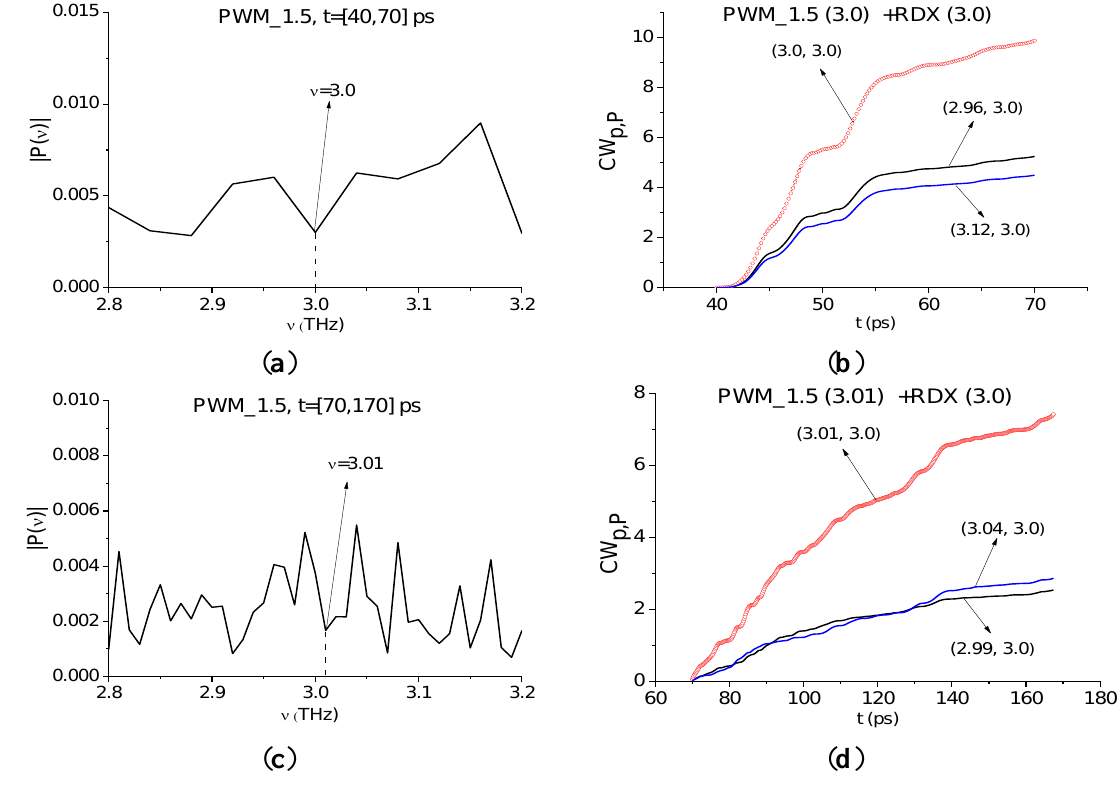
Figure 26. Fourier spectra of the first sub-pulse ( a ) and the remote part ( c ) of the PWM_1.5 signal in the frequency range ν = [2.8, 3.2] THz; integral characteristics CW p , P ( t n ) detecting the frequencies ν = 3.0 THz ( b ); 3.01 THz ( d ) in the time intervals t = [40,70] ps ( b ) and t = [70,170] ps ( d